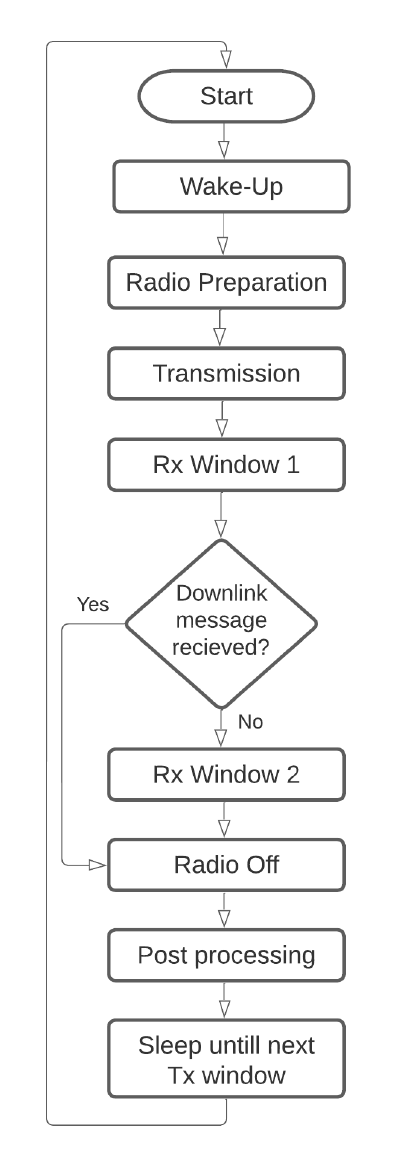
Figure 5. End-node procedure in synchronized